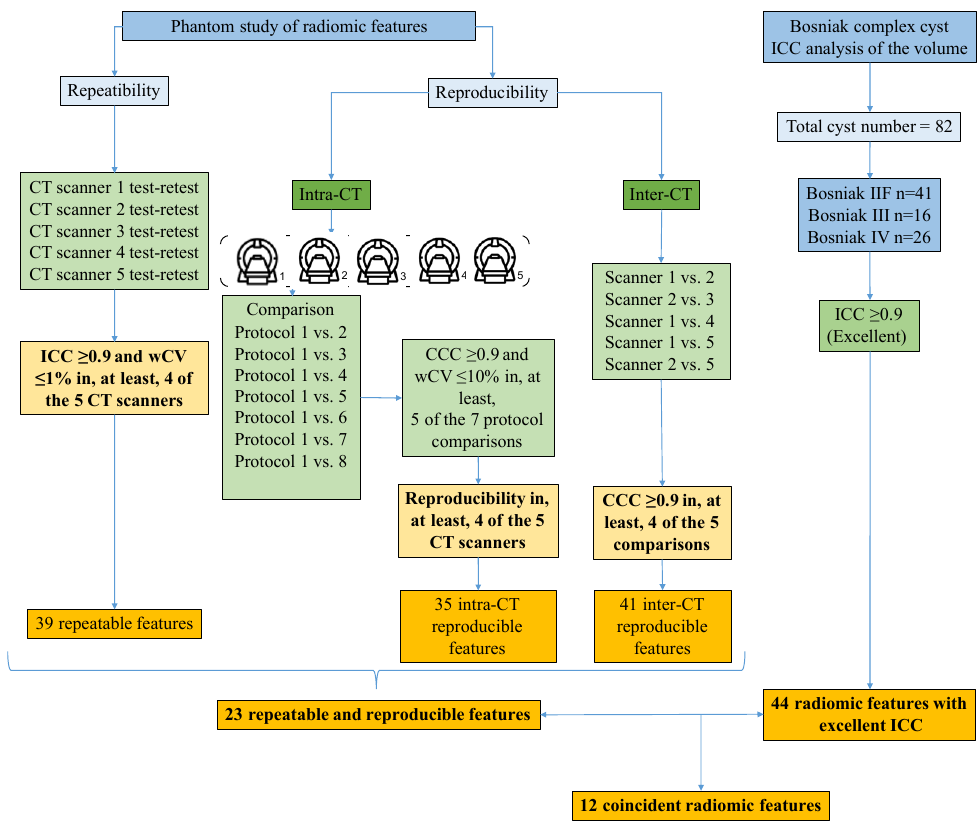
Figure 1. Flowchart of repeatability and reproducibility analysis of phantom assays and its compari- son with Bosniak cyst feature statistical analysis. Table 2. Demographic information of the benign and malignant cysts groups. The anatomopathologi- cal results of malignant cysts are